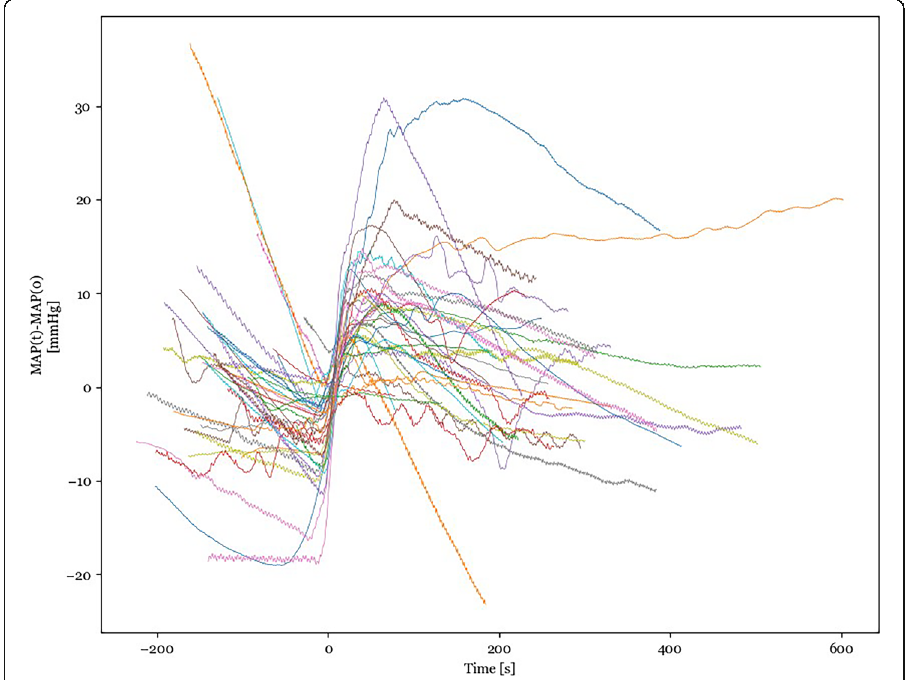
averaged as a function of time. The mean aortic pressure responses are represented by the blue line in Fig. 2. The shaded region above and below the blue line represents the standard deviation of those values. The mean pressures and the standard deviation of the pressures approaches zero as the time approaches zero due to the normalization procedure discussed in the methods. Comparing blood pressures from the timespan